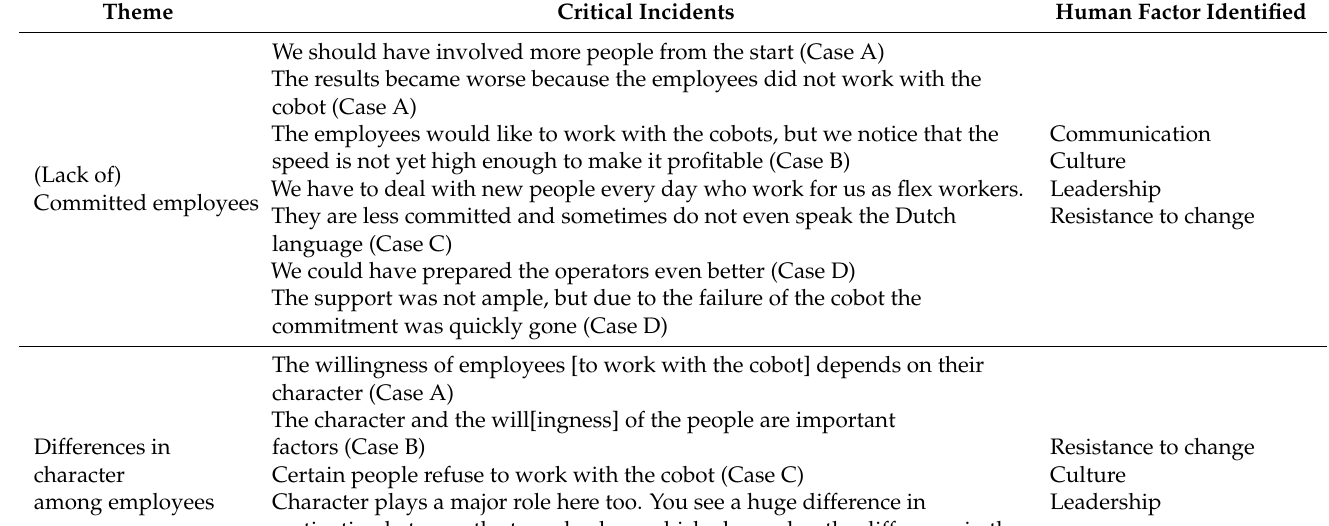
Table 5. Critical incidents and human factors identified related to the commitment, character, and motivation of employees during the implementation